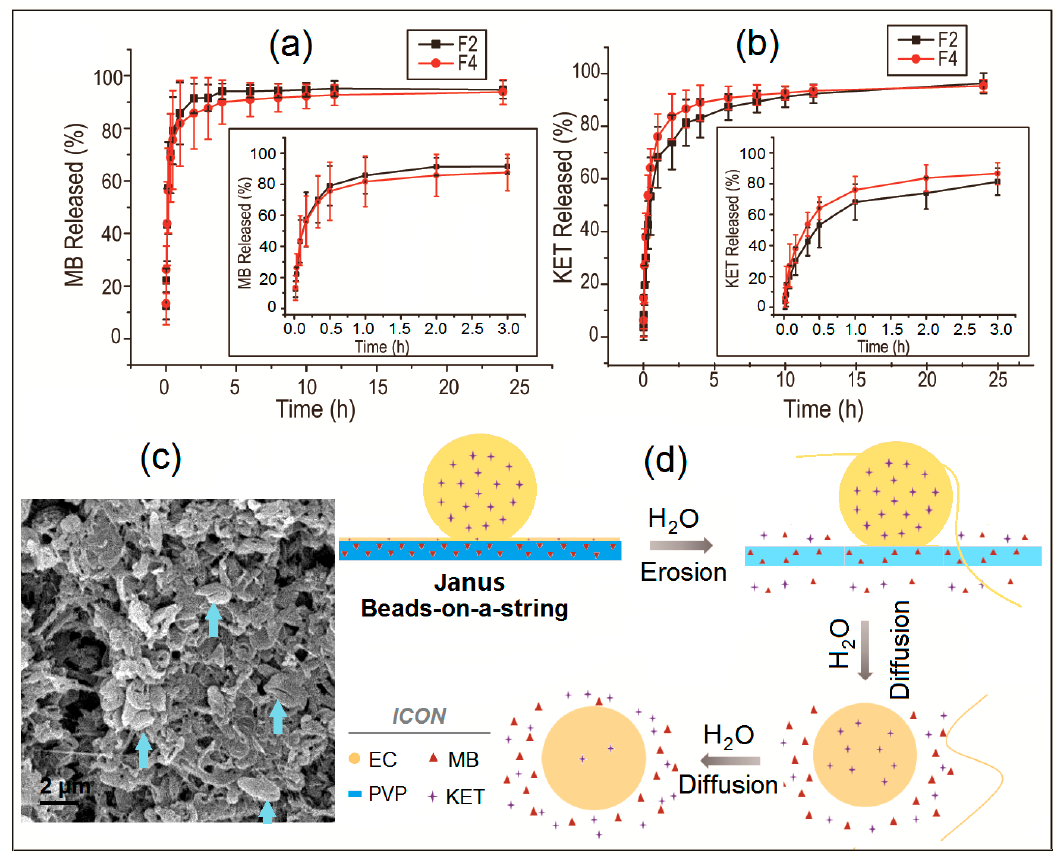
Figure 6. In vitro drug release profiles and mechanisms: ( a ) MB; ( b ) KET; ( c ) An SEM image of the residue EC particles after in vitro dissolution tests; ( d ) A diagram about drug release mechanisms.